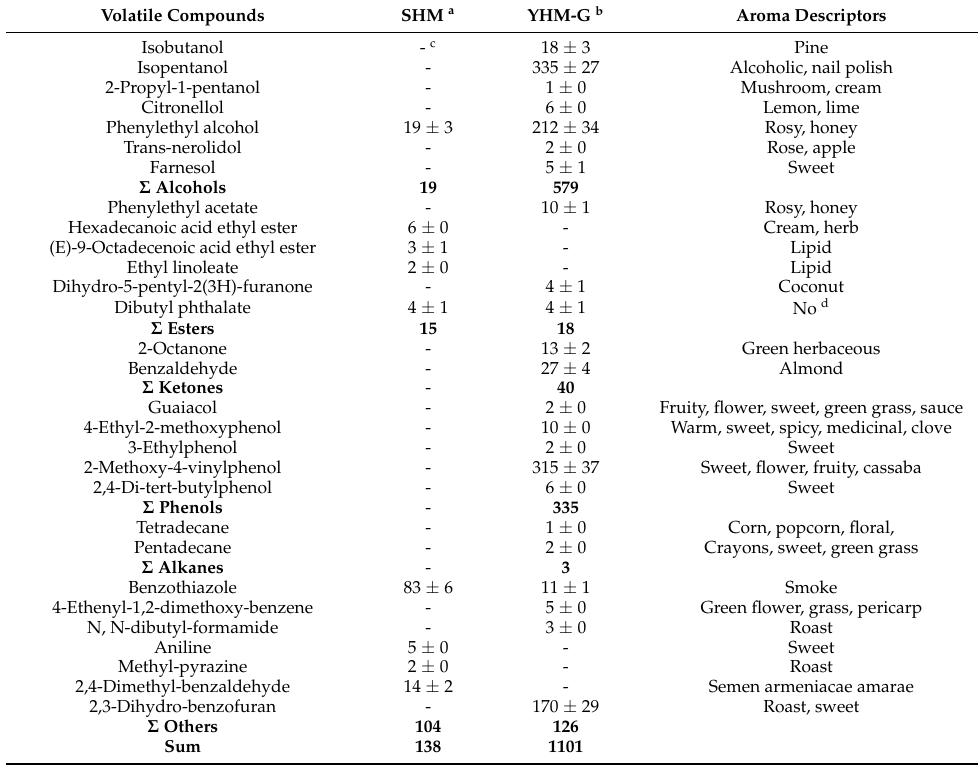
Table 8. The volatile compounds in SHM with or without YHM-G ( µ